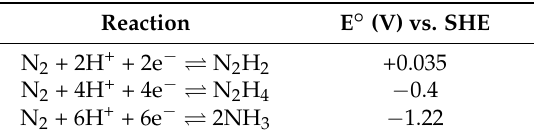
Figure 4 . Schematic of semiconductor-based photocatalyst used for the N 2 fixation. The redox potentials (Potential (E) vs. Normal Hydrogen Electrode (NHE)) of half reaction water oxidation and dinitrogen protonation are marked on the left. Table 1. Reduction potentials (vs. Standard Hydrogen Electrode (SHE)) of typical hydrogenation reactions relate to the reduction of N 2 to NH